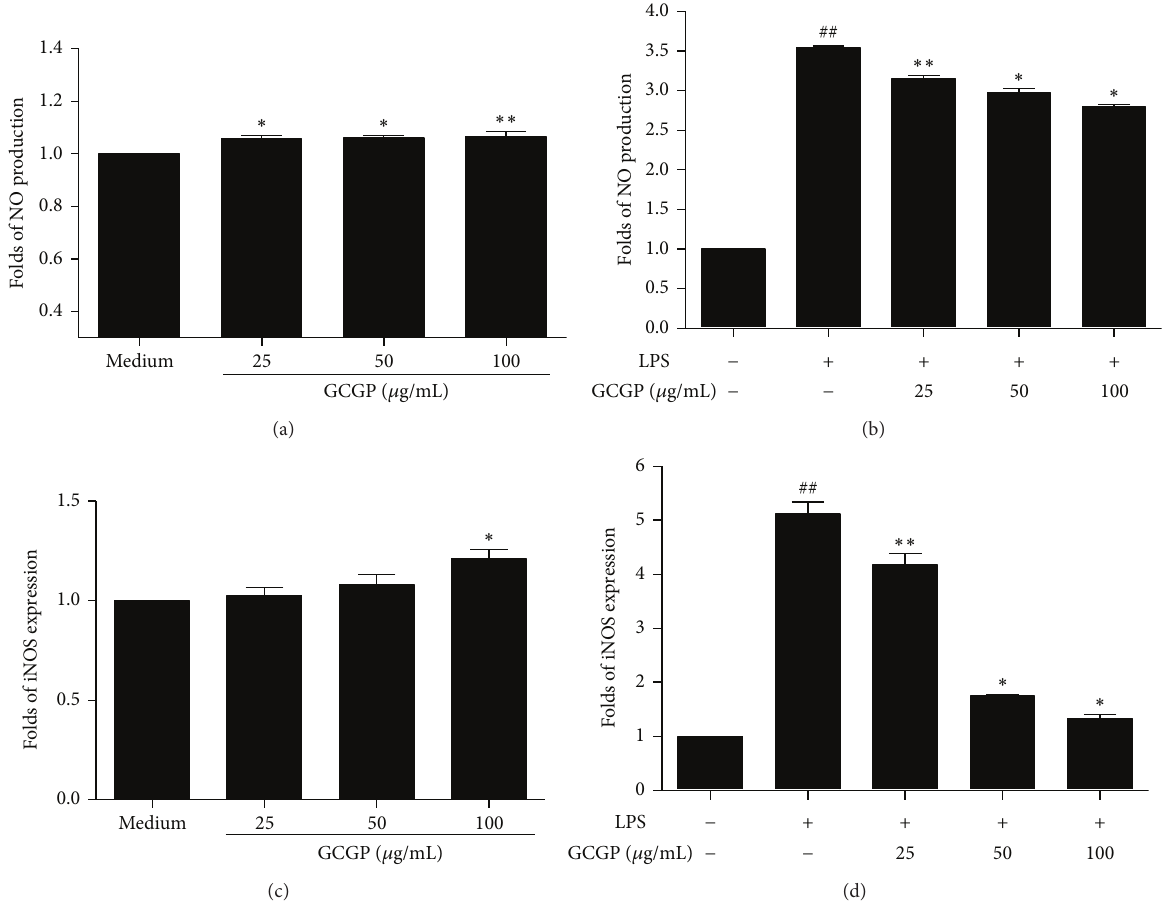
Figure 1: Effect of GCGP on NO production and iNOS expression in RAW264.7 cells ((a) and (c)). Cells were treated with the indicated concentrations of GCGP for 24 h ((b) and (d)). Cells were treated with the indicated concentrations of GCGP for 1h prior to 5 𝜇 g/mL LPS for 24 h. NO production and iNOS expression were analyzed as described in Materials and Methods. Results correspond to the mean ± SD of three independent experiments. ## 𝑃 < 0.01 versus control, ∗ 𝑃 < 0.05 , and ∗∗ 𝑃 < 0.01 versus medium or LPS